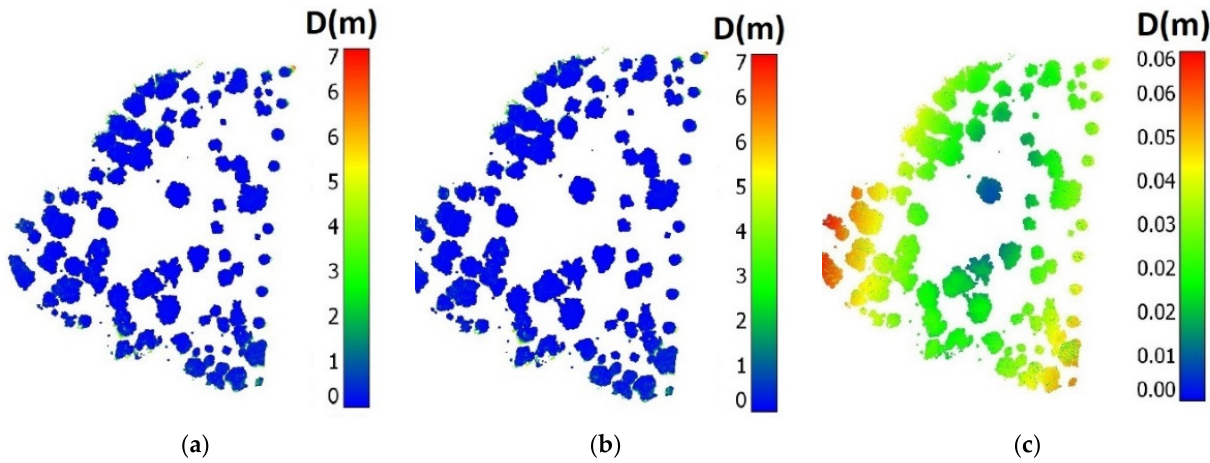
Figure 12. Distance between the point clouds: ( a ) original photogrammetric and LiDAR point clouds, ( b ) registered pho- togrammetric and LiDAR point clouds and ( c ) original and registered photogrammetric point clouds.